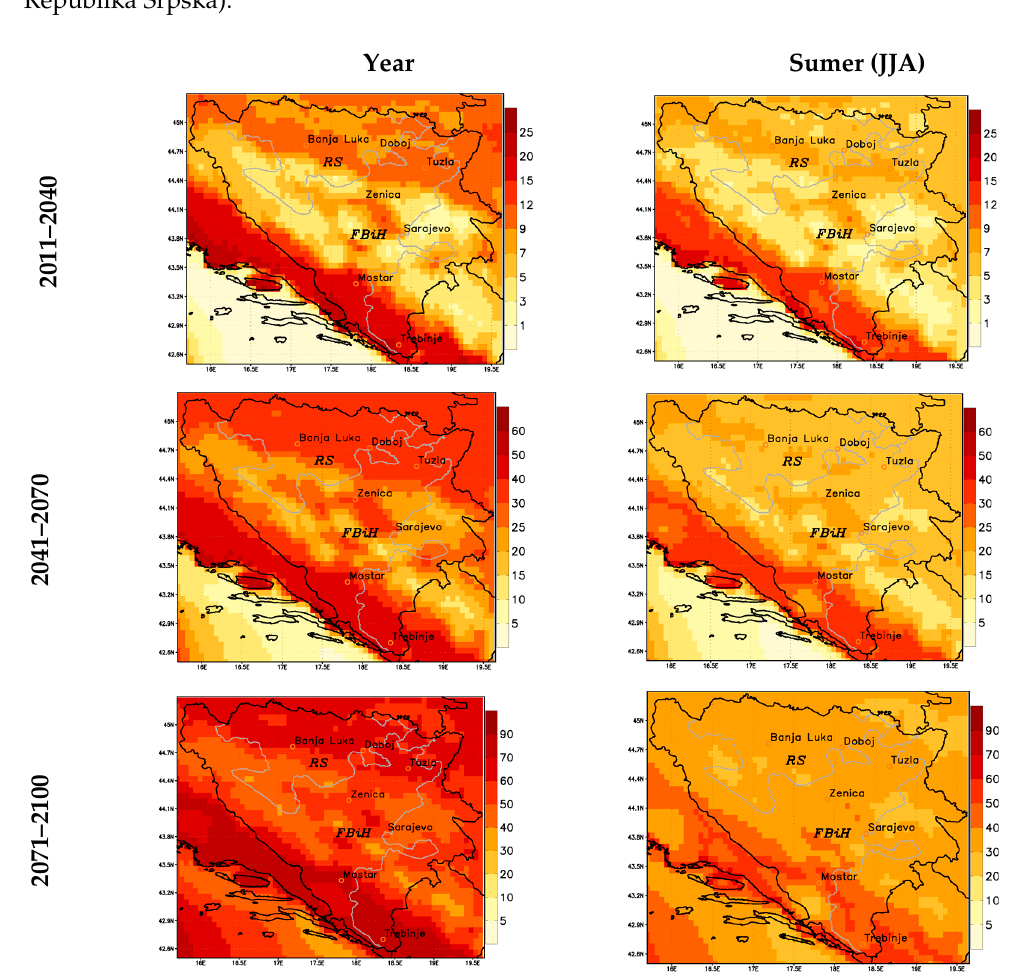
Figure 2. Change of the TX25 index at the annual level and for the JJA season, in days/years, for the periods 2011–2040, 2041–2070 and 2071–2100 in relation to the period 1971–2000, according to the future climate scenario RCP8.5.